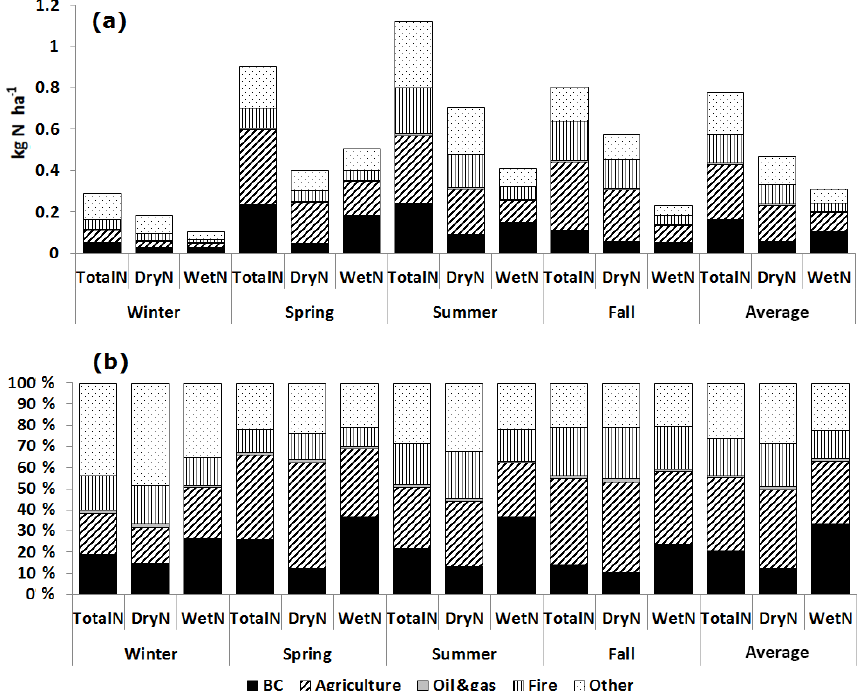
Figure 7. Contributions of source sectors to the mean total N r deposition, dry N r deposition, and wet N r deposition over the GYA in different seasons in 2011. (a) The source sector contributions as an absolute and (b) the corresponding contributions as a